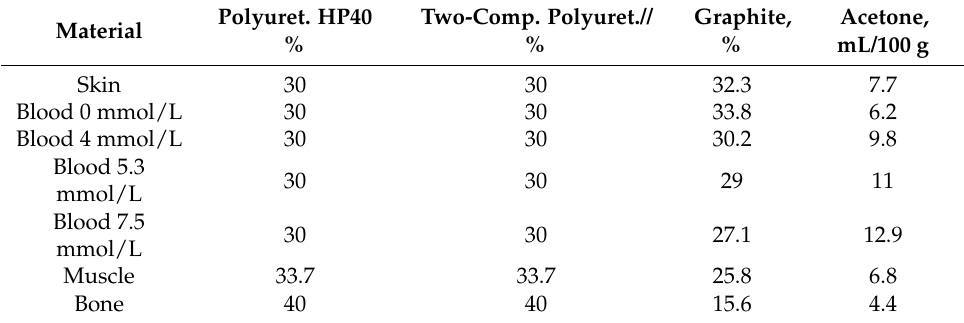
Table 2. The calculated data on the components for the phantom.